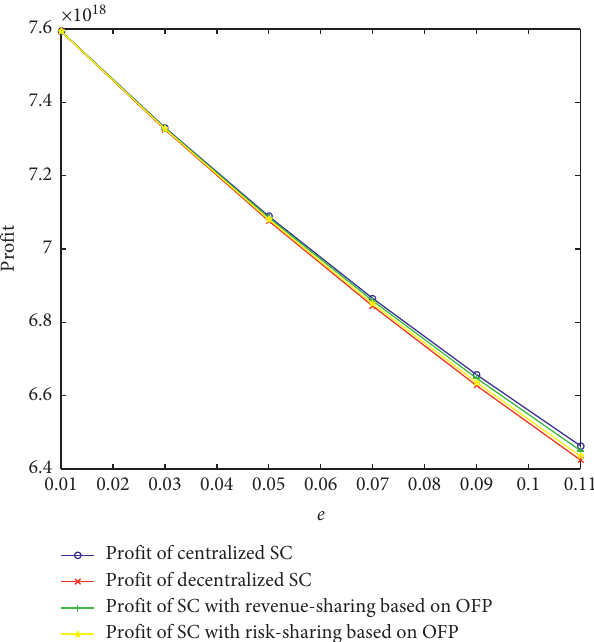
Figure 2: SC performance under the cooperation of STO and YTO with the change trend of nonscale economic cost e .